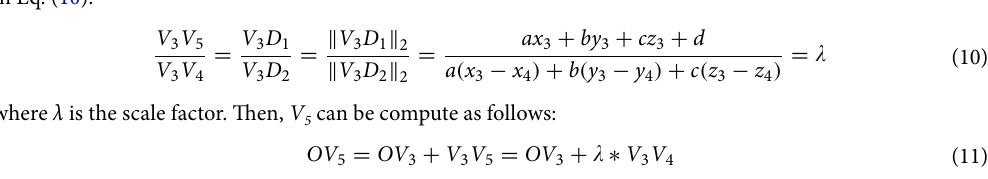
points are marked with D 1 ( x d 1 , y d 1 , z d 1 ) and D 2 ( x d 2 , y d 2 , z d 2 ), respectively. Obviously, the scale at the projection line divided by D 1 is the same as the intersection line divided by the intersection point V 5 ( x 5 , y 5 , z 5 ), as shown in Eq. (10).